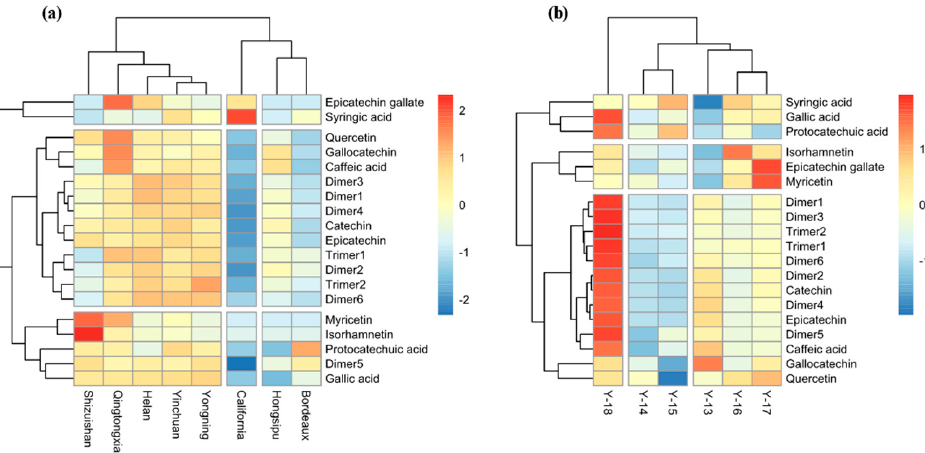
Figure 6. HCA (hierarchical cluster analysis) of wines based on phenolic c ompounds from the six sub-regions of Ningxia, Bordeaux, and California ( a ) wines from the six vintages (2013–2018) from the Ningxia region of China ( b ).